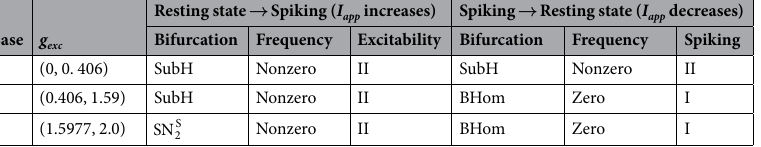
Table 3. Three cases of bifurcations corresponding to neuronal excitability/spiking classes induced by the excitatory